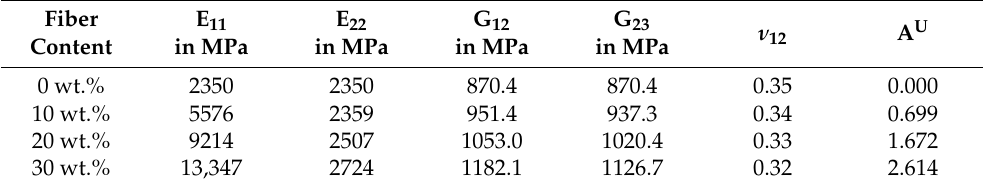
Table 2. Elastic constants and degree of anisotropy for transversely isotropic FRP with varying fiber content, calculated with the Tandon-Weng model [21] and according to